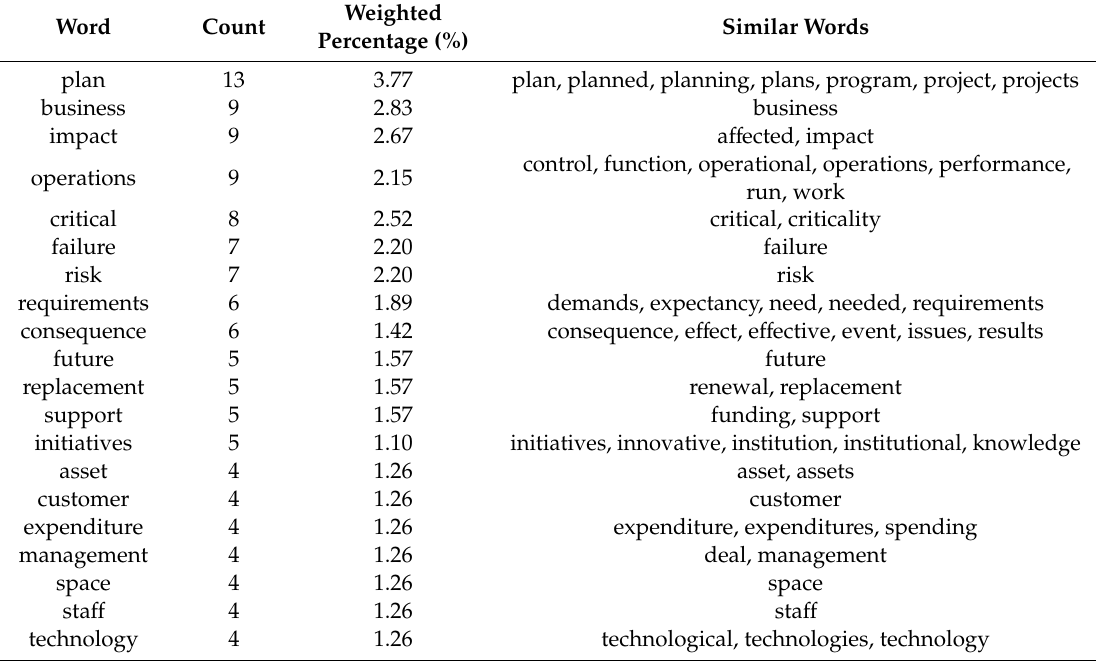
Table 5. The results of content analysis in NVivo software.